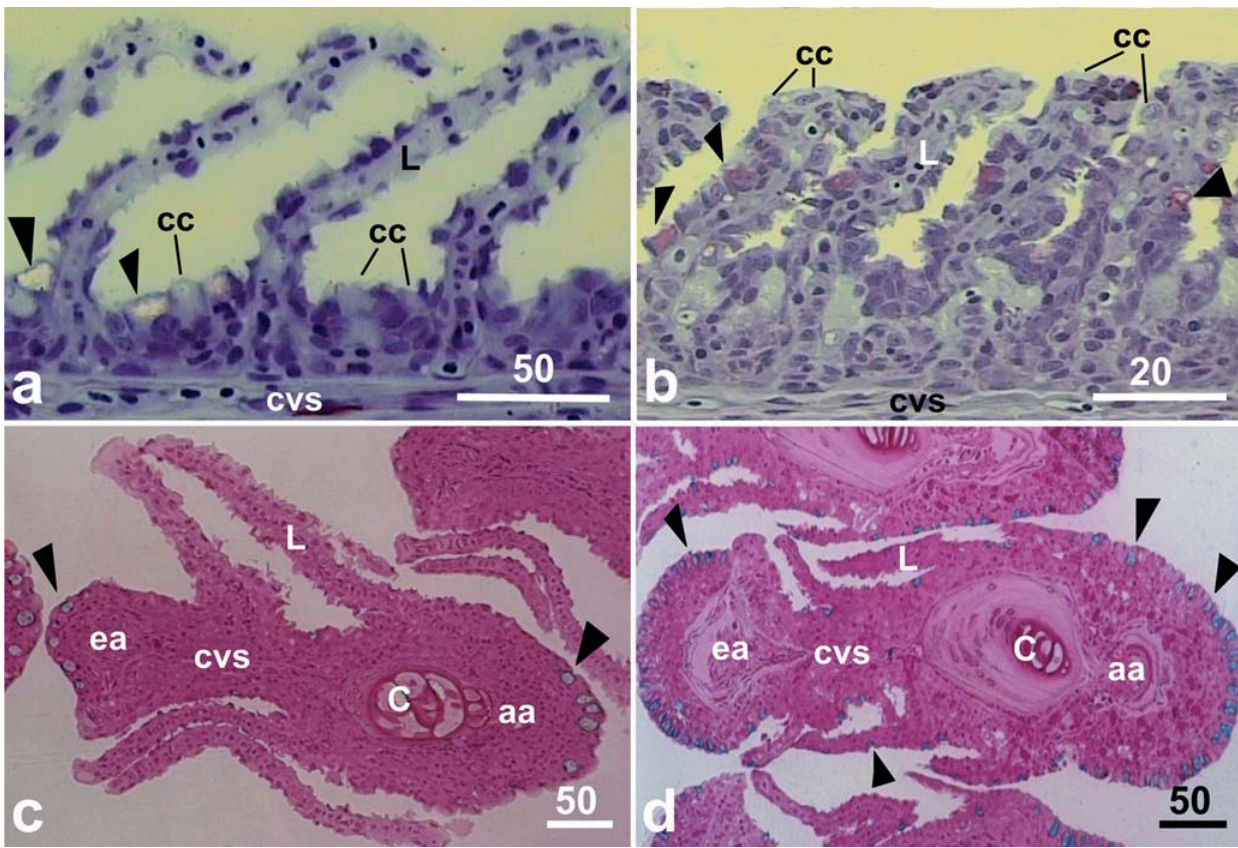
Fig. 1. a-b. Saggital section of gill filament showing filament and lamellar epithelium. c-d. Cross section of filament showing the distribution of mucous cells (arrowheads). a and c , Hoplias malabaricus . b and d , Hoplerythrinus unitaeniatus . Scale bar in mm. aa - filament afferent artery, c - cartilage, cc - chloride cell, cvs - central venous sinus, ea - filament efferent artery, L -